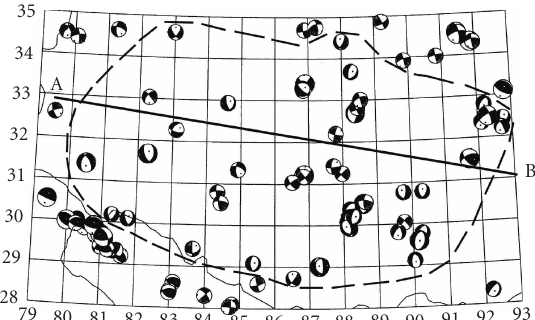
Figure 9: Distribution of the fault plane solutions of earthquakes in and around the AB region of the Tibetan plateau in Figure